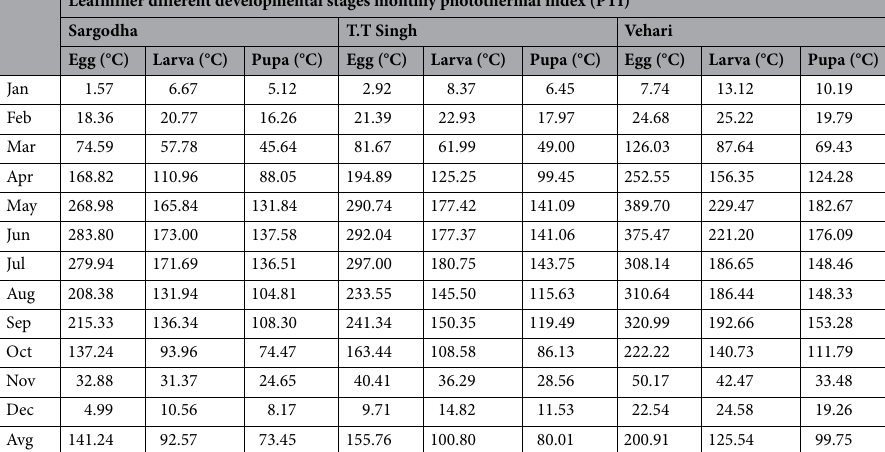
Table 5. Leafminer developmental stages photothermal index.